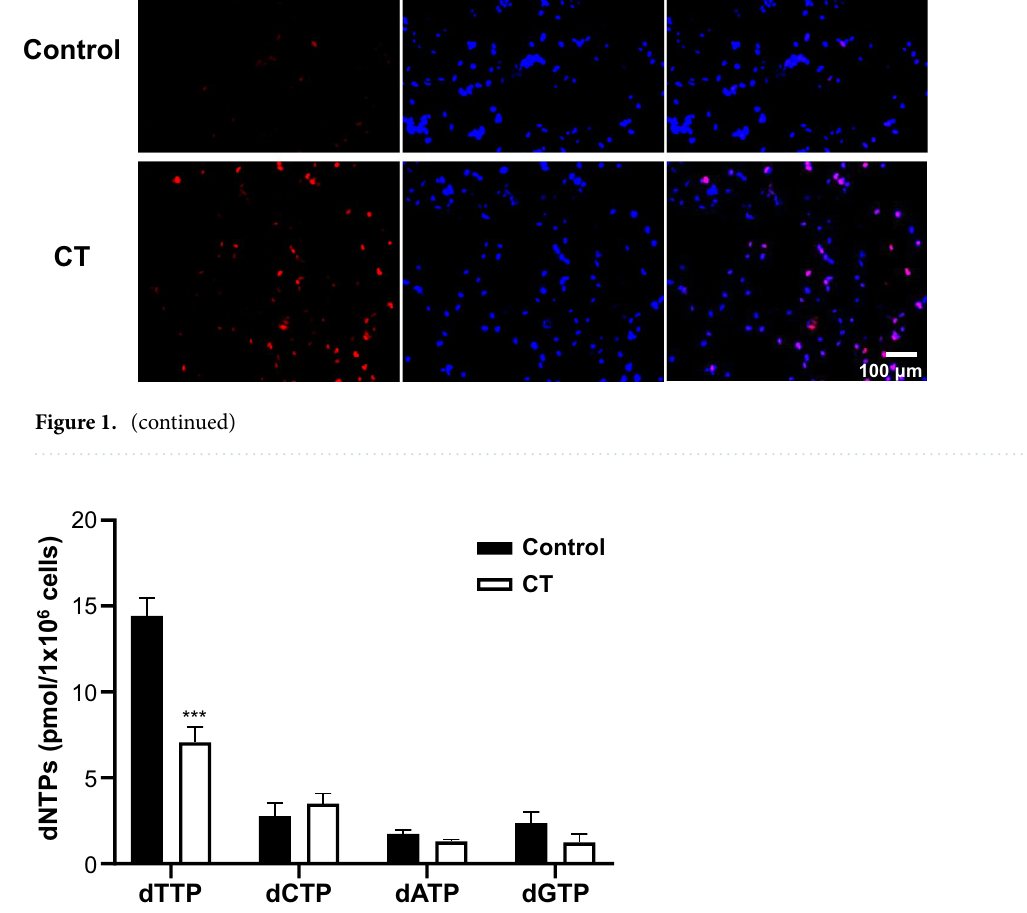
Figure 2. Changes in intracellular dNTP pools in MDA-MB-231 following CT transfection. EvaGreen-based assay for dNTPs using 197-nt templates was carried out for quantification of dNTP pools in MDA-MD-231 cells after CT transfection (1.25 μg/5 × 10 5